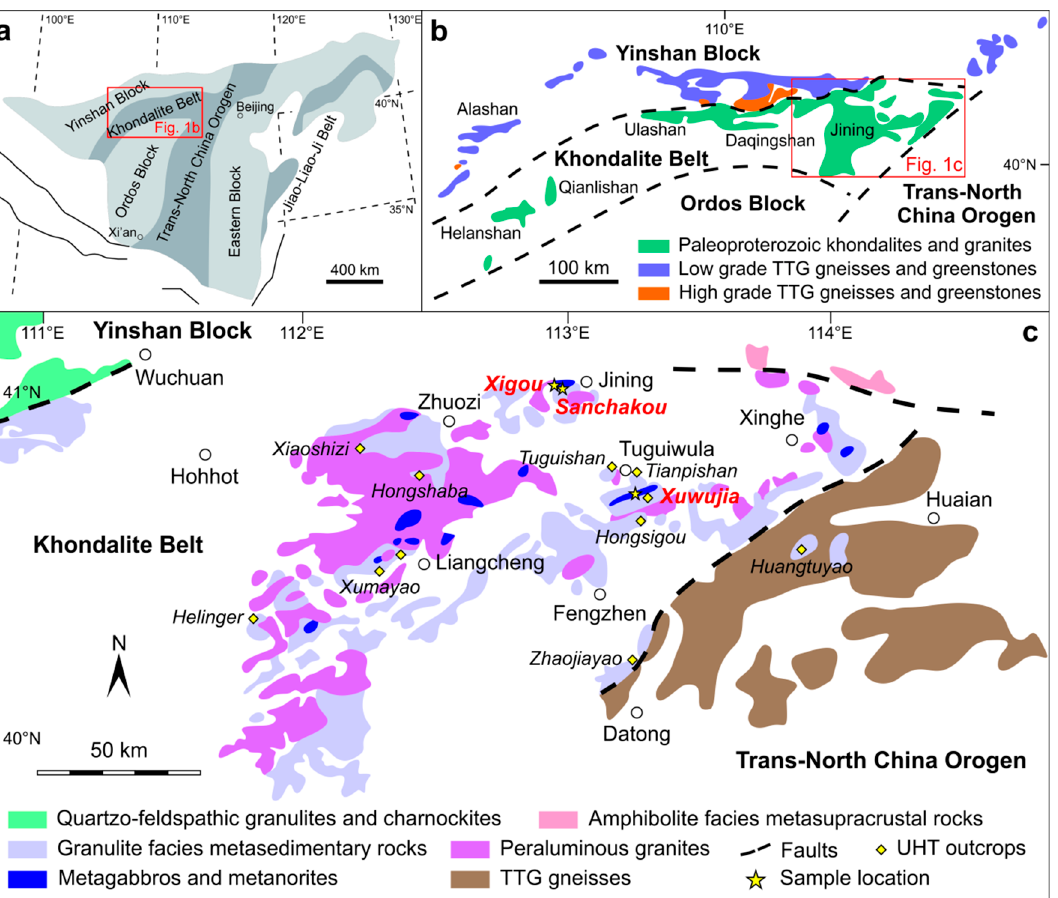
Figure 1. The regional geological map of the Jining terrane in the Khondalite Belt of the NCC. ( a ) The structural sketch of the NCC (modi fi ed from [20]); ( b ) The distribution map of structural units contained in the Khondalite Belt and adjacent structural units of the Khondalite Belt (modi fi ed from [20]); ( c ) The lithology distribution map of the Jining terrane (modi fi ed from [34]).